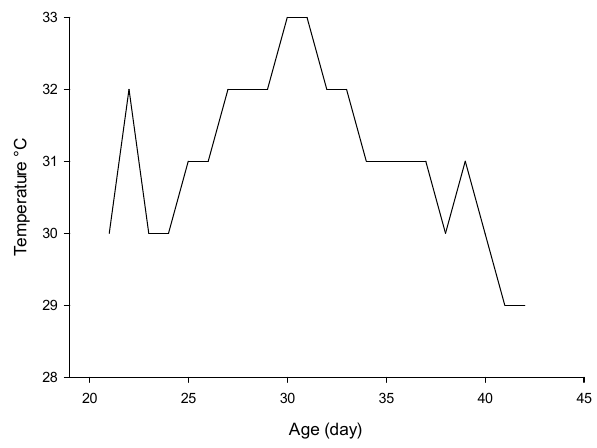
Figure 1. The average daily temperature of the chicken house from 10:00 to 18:00 local time (GMT + 4:30.